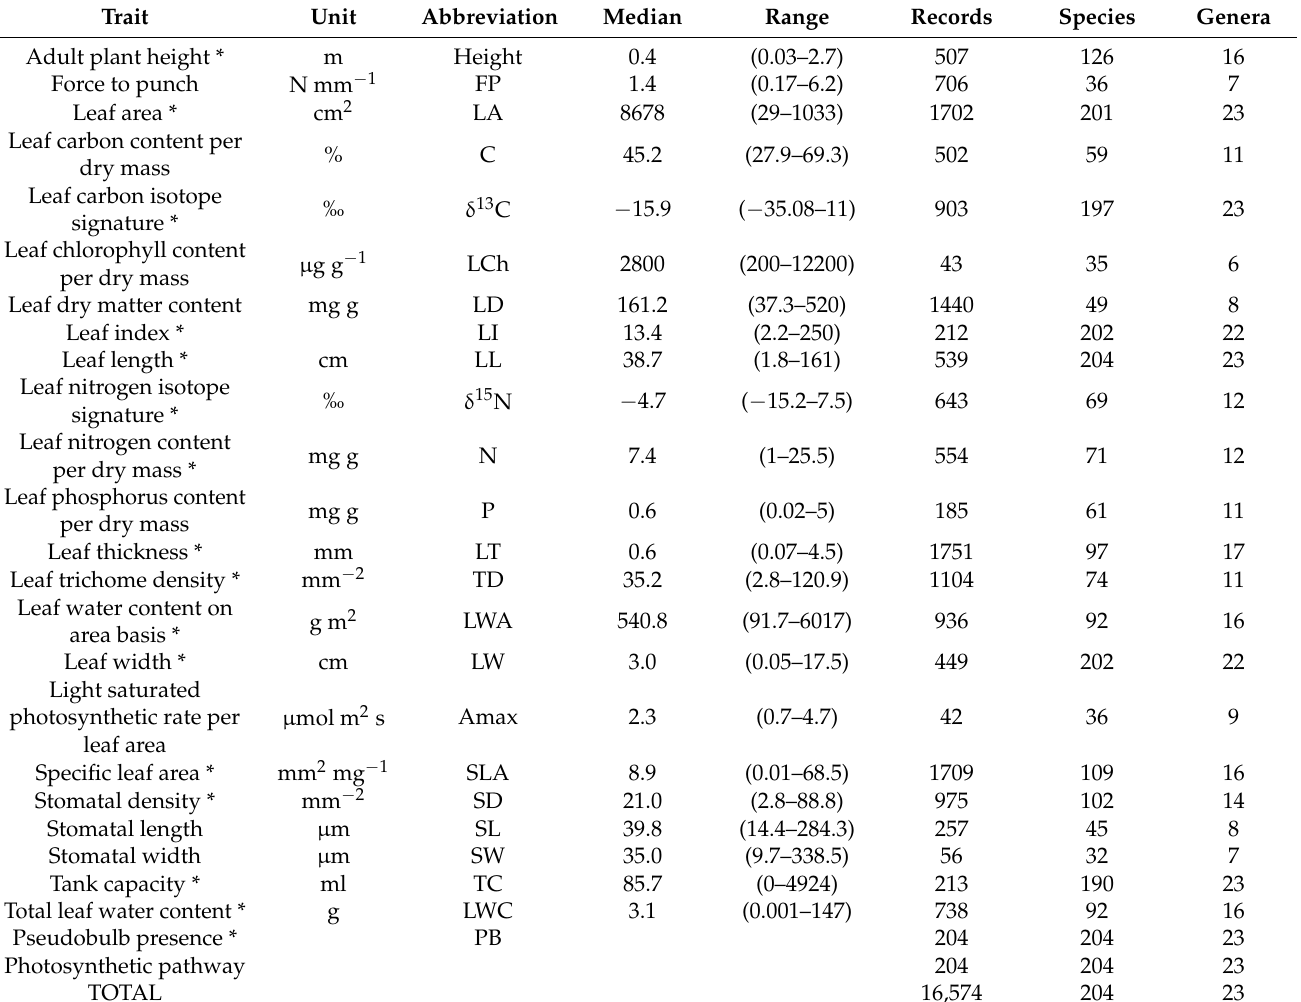
Table 1. Functional trait units, abbreviations, medians, ranges, total number of records, and repre- sented species and genera. Photosynthetic pathways = CAM, C 3 , CAM/C 3 . * Denotes variables used in hierarchical